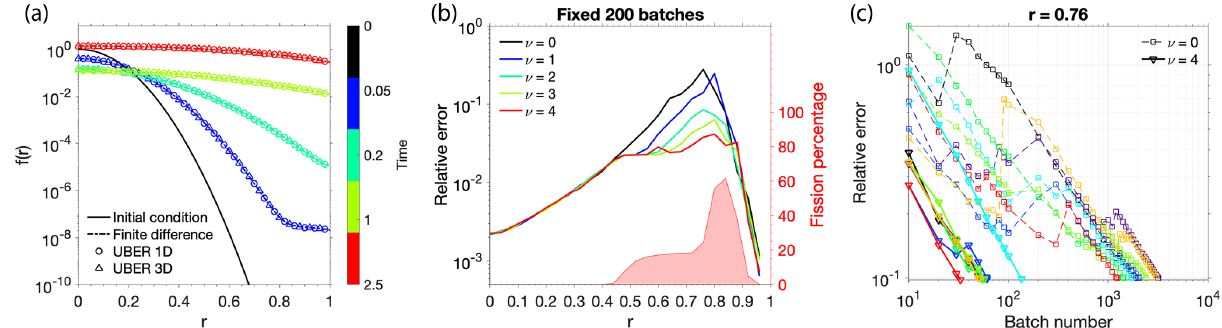
Figure 2. (a) UBER and finite-difference solutions (dashed line) to the problem in Eqs. (24)–(27). The UBER 1D solutions (circles) are ob- tained in a one-dimensional spherical coordinate system, and the UBER 3D solutions (triangles) are obtained in three-dimensional Cartesian coordinates along a sphere radius. (b) Left y axis: the relative errors of the UBER 3D solutions at T = 0 . 05, respectively obtained with the same total number of stochastic processes (2048 per batch) but different upper limits of offspring generations ( ν ) in the process-splitting technique. ν = 0 means the process splitting is turned off. Right y axis: the percentage of stochastic processes that have undergone splitting for ν = 4. (c) The reduction of relative errors with an increasing number of stochastic processes at the slowest-converging solution point ( r = 0 . 76) for ν = 0 (dashed line and squares) and 4 (solid line and triangles). Colors denote different numerical experiments.